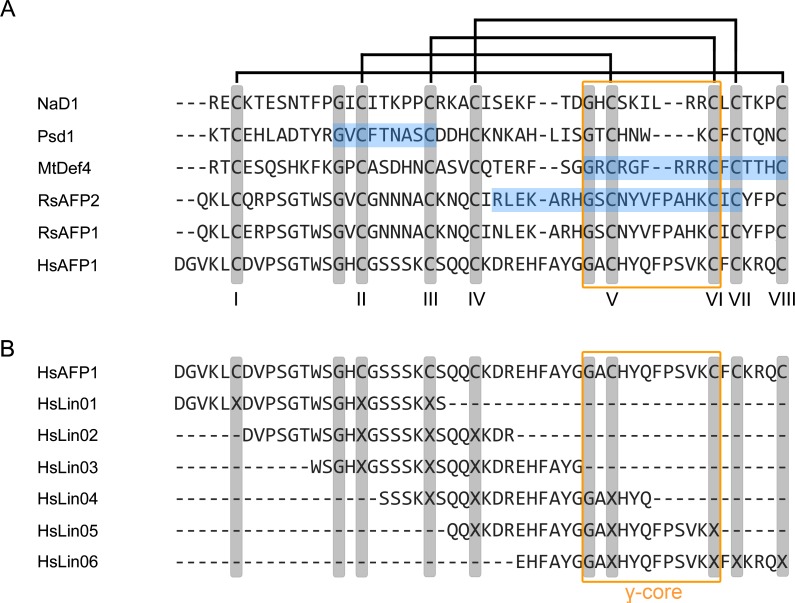
Sequence alignment of HsAFP1 with other plant defensins.(A) Amino acid sequence alignment of NaD1 [6], Psd1 [5], MtDef4 [61], RsAFP1 [62], RsAFP2 [62] and HsAFP1 [32], matching their cysteine residues (numbered I-VIII). Multiple alignment was performed using the COBALT alignment tool [63]. Cysteine-pairing is shown at the top of the figure. Highly conserved residues are shown in grey; (-) denote gaps in the alignment. Blue boxes represent peptide fragments that exhibit antifungal activity similar to the parental peptide, and hence, are important for antifungal activity [4,64–66]. The orange box indicates the position of the γ-core. (B) Amino acid sequence alignment of HsAFP1 and the HsAFP1 linear peptide fragments (HsLin01-HsLin06). Multiple alignment was performed using the COBALT alignment tool [63]. Highly conserved residues are shown in grey; (-) denote gaps in the alignment. The orange box indicates the position of the γ-core.